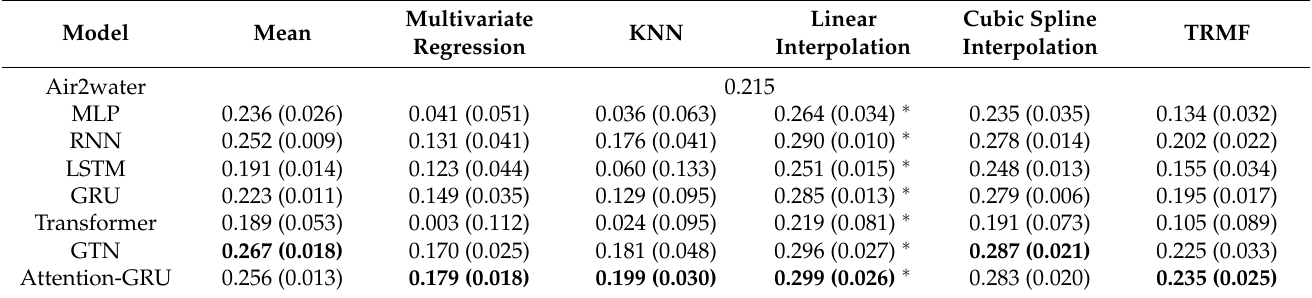
Table 7. The values of the evaluation index NSE. The values in the table represent the mean (standard deviation) of the ten experimental results. The best prediction model results for each missing value imputation method are shown in bold. “ ∗ ” represents the best result for the prediction